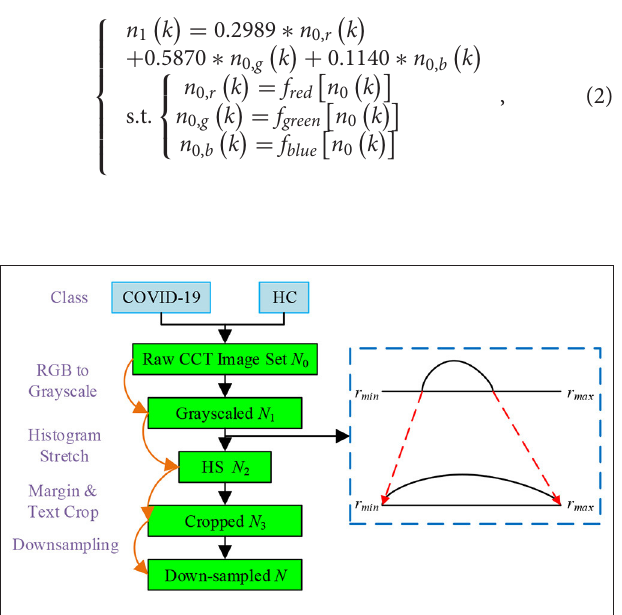
FIGURE 3 | Schematic of preprocessing.